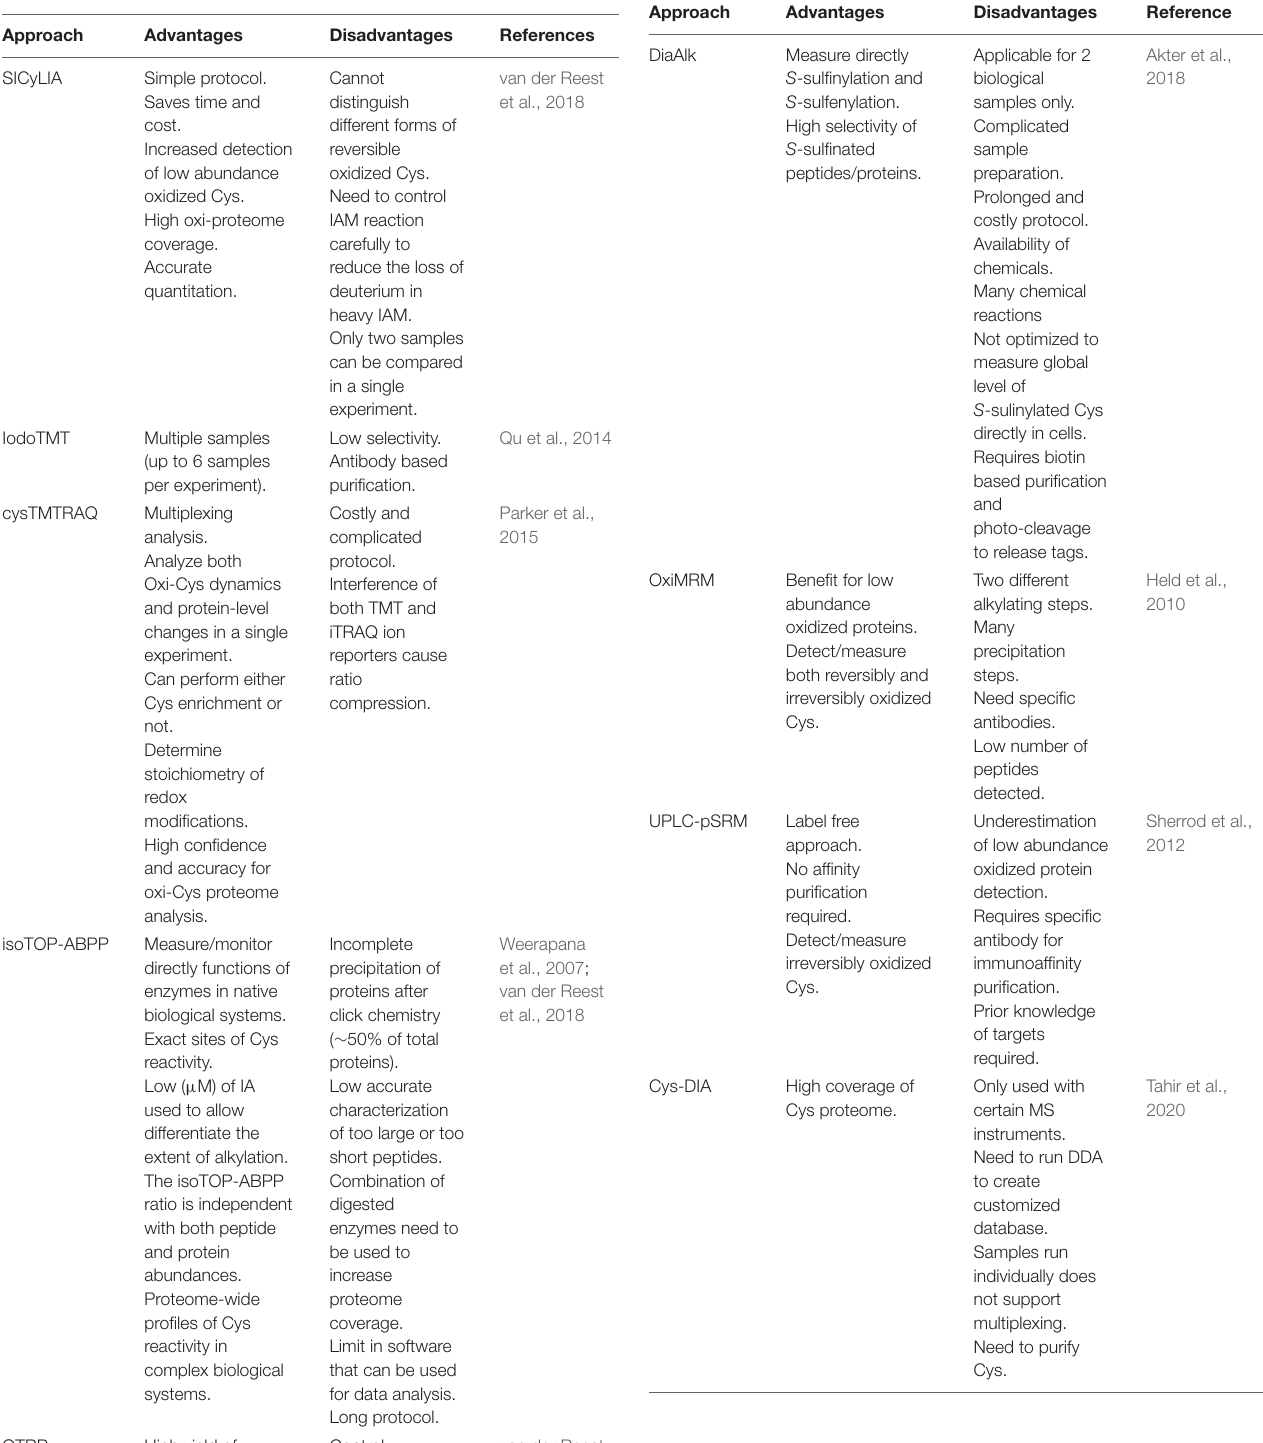
TABLE 1 | Advantages and disadvantages of current Oxi-Cys proteomic